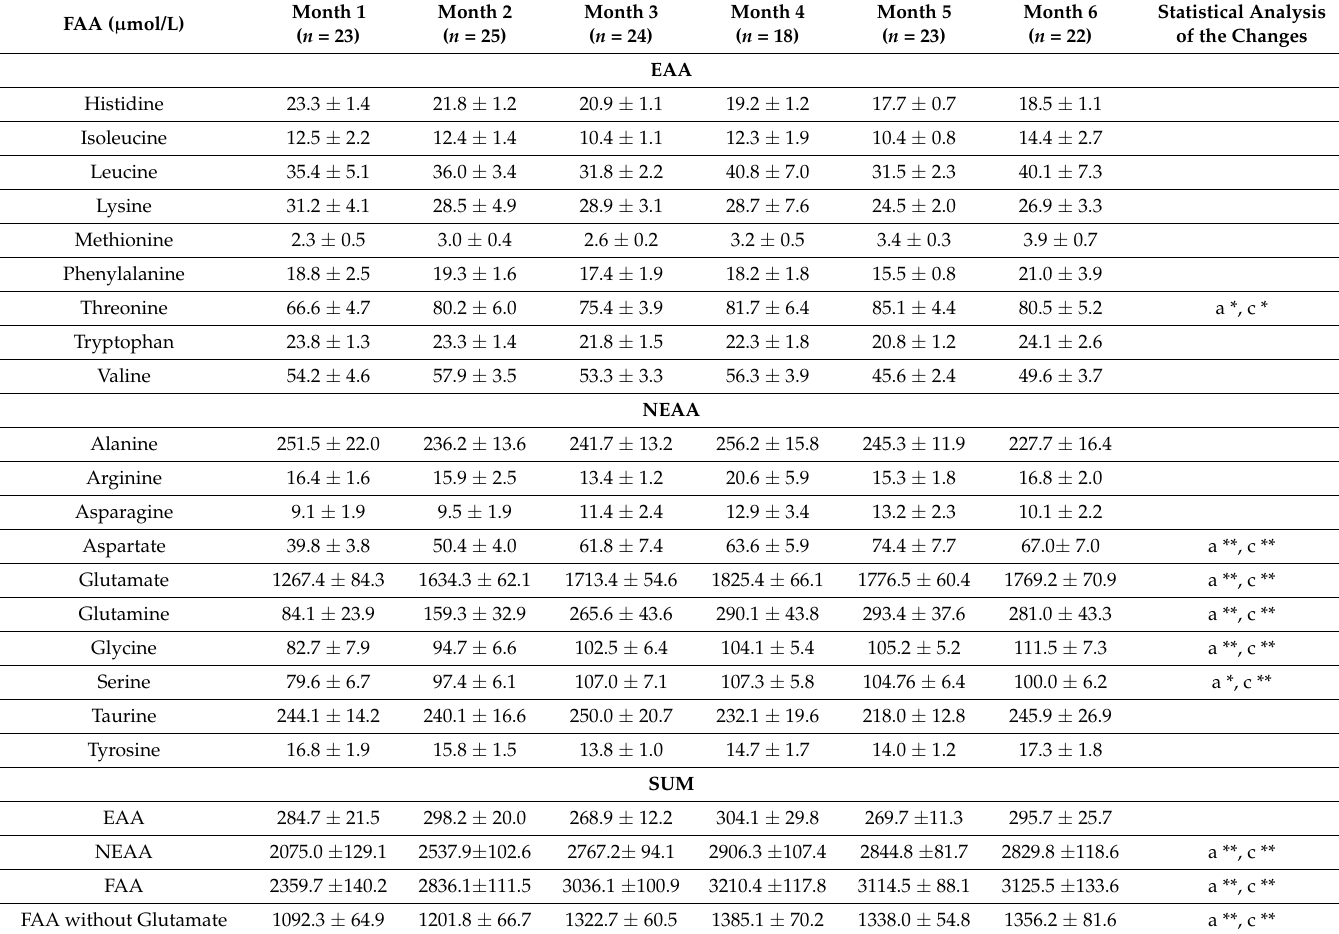
Table 2. Free amino acid levels in human milk during months 1–6 of